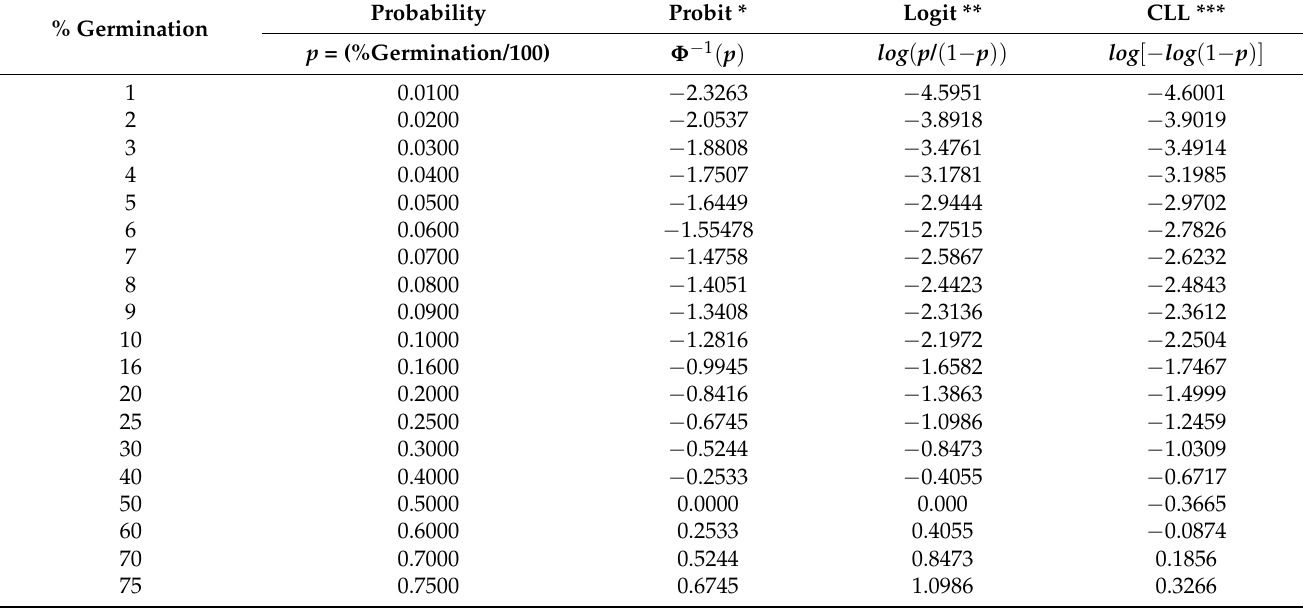
Table 2. Standard table for calculating the germination probabilities obtained by the Probit, Logit and Complementary log-log (CLL)